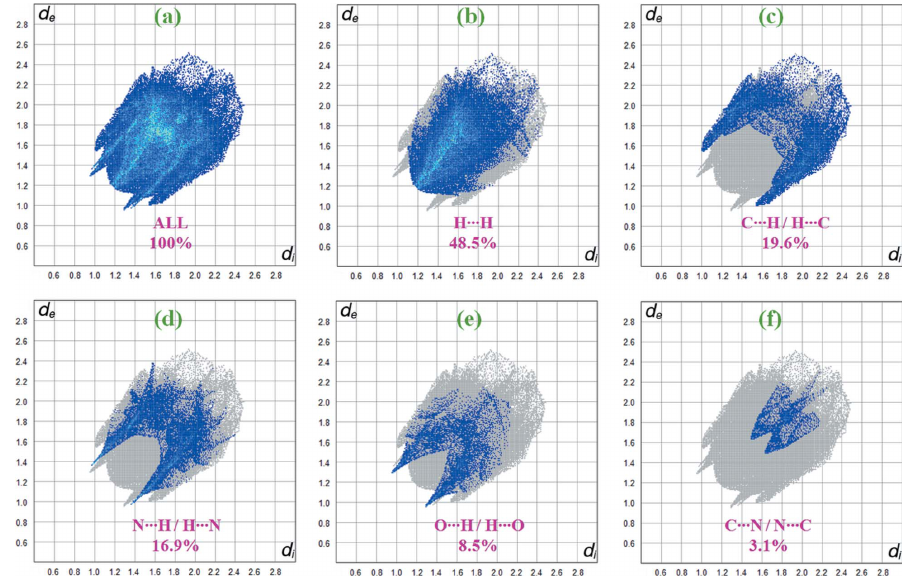
Figure 8 2D fingerprint plots for compound II , with a d norm view and the relative contributions of the atom pairs to the Hirshfeld